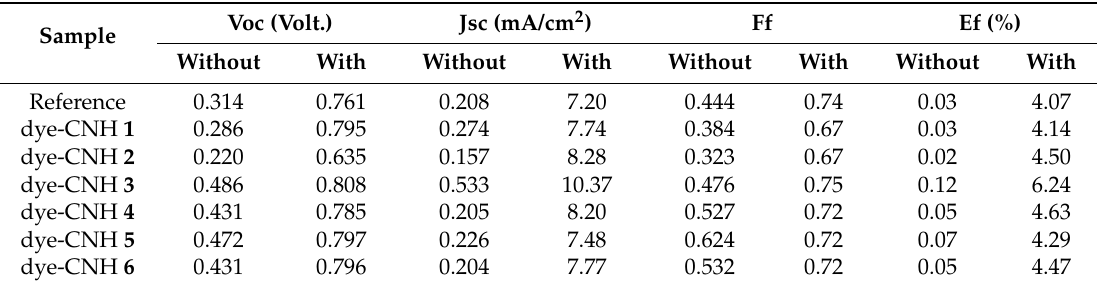
Table 1. Performance data for the photovoltaic devices prepared with dye-CNHs samples as additives in the absence or presence of N719 dye.